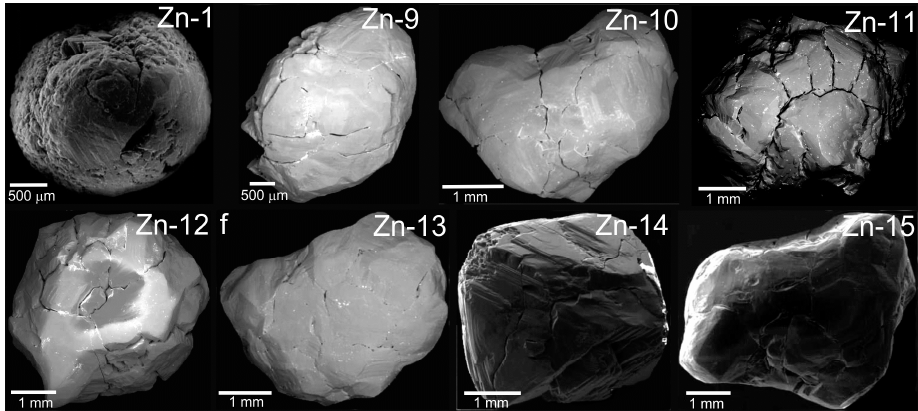
Figure 2. Morphology of diamonds (SEM images).